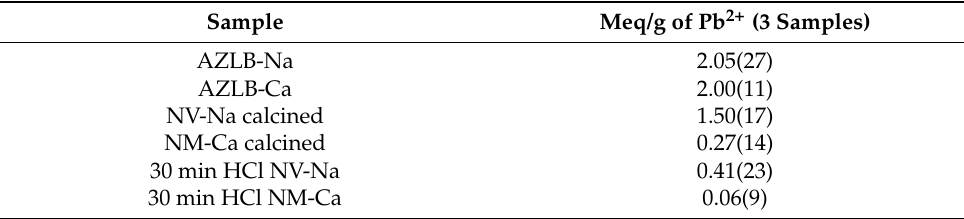
Figure 14. The ATR-FTIR spectra of Calcined NV-Na, 30 min HCl NV-Na, Calcined NM-Ca, and 30 min HCl NM-Ca. Table 5. The Pb 2+ removal by the zeolites at a time of 5 days at 35 ◦